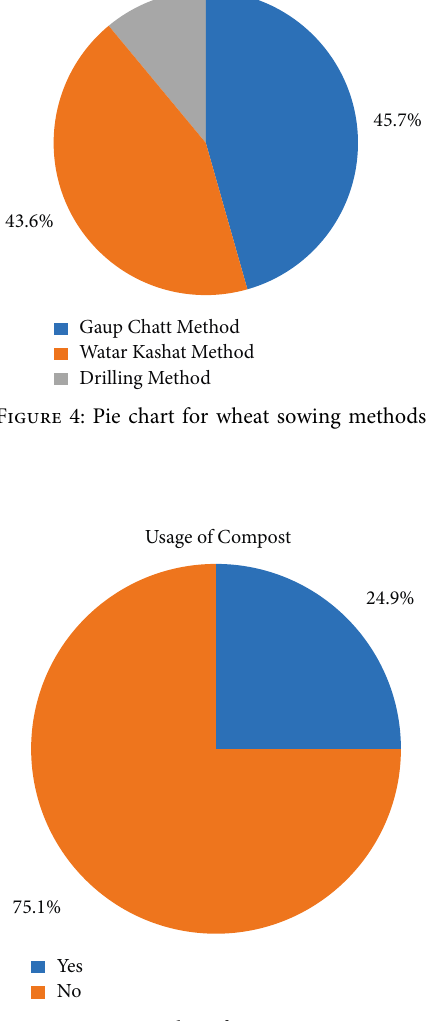
Figure 5: Pie chart for using